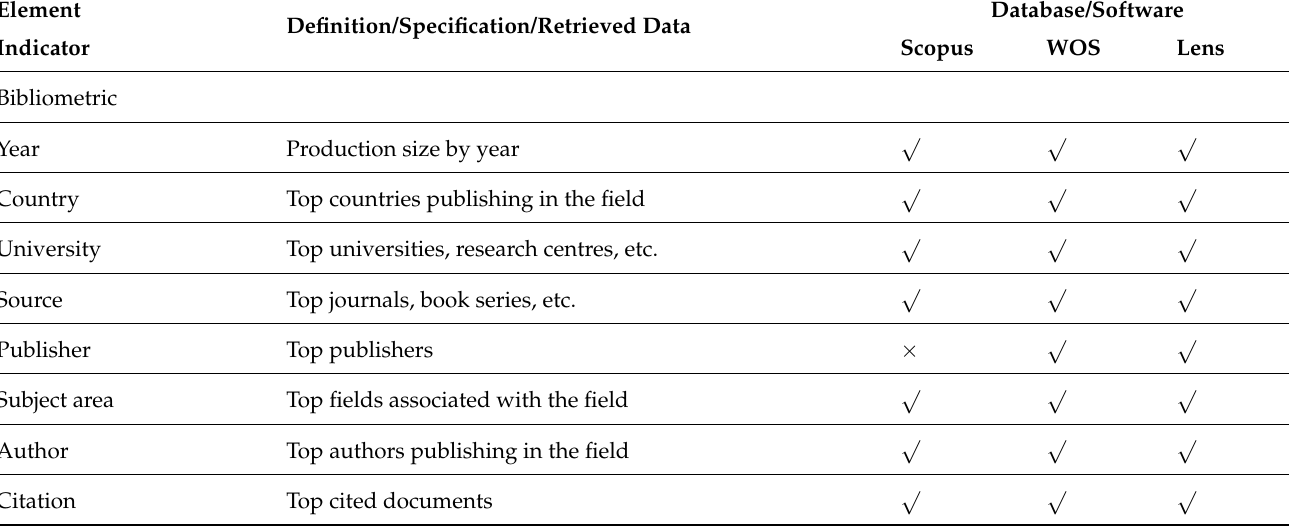
Table 1. A List of bibliometric and scientometric indicators based on